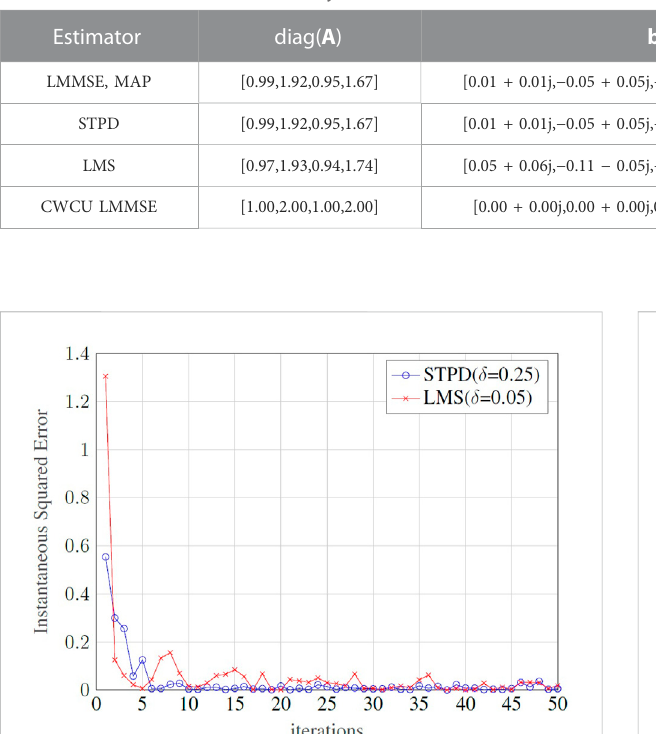
FIGURE 7 FLOP counting for the presented linear